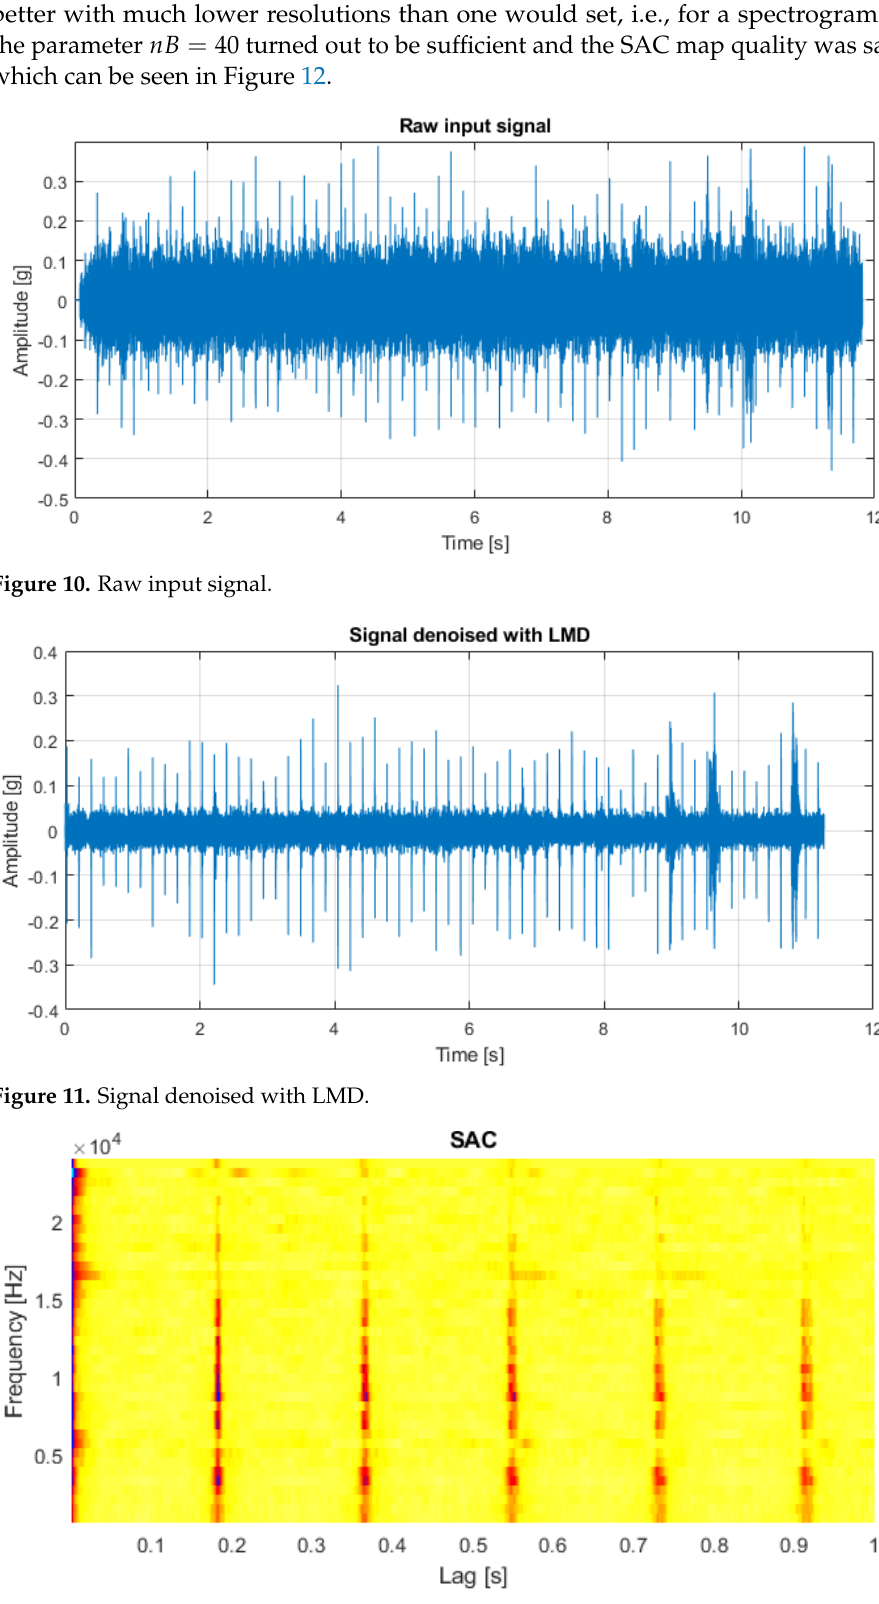
Figure 12. Spectral autocorrelation